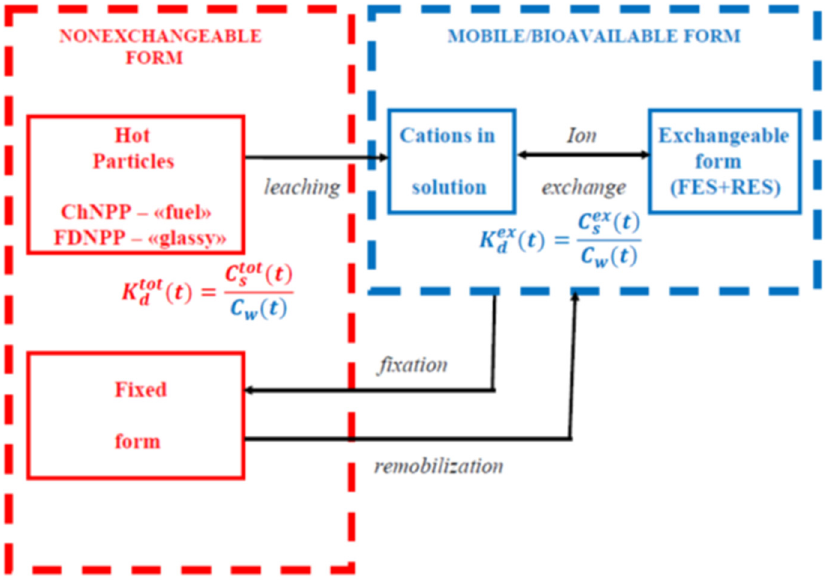
Figure 1. Scheme of basic transformation processes of radiocesium speciation in soil–water environment (modified after [27,53]). Blue compartment includes dissolved and exchangeable radiocesium (mobile and bioavailable forms; Red compartment includes non-exchangeable forms of radiocesium (excluded from exchange with water in immediate term). Reprinted/adapted with permission from Ref. [27]. Copyright year 2020, copyright owner’s name SPRINGER Nature.